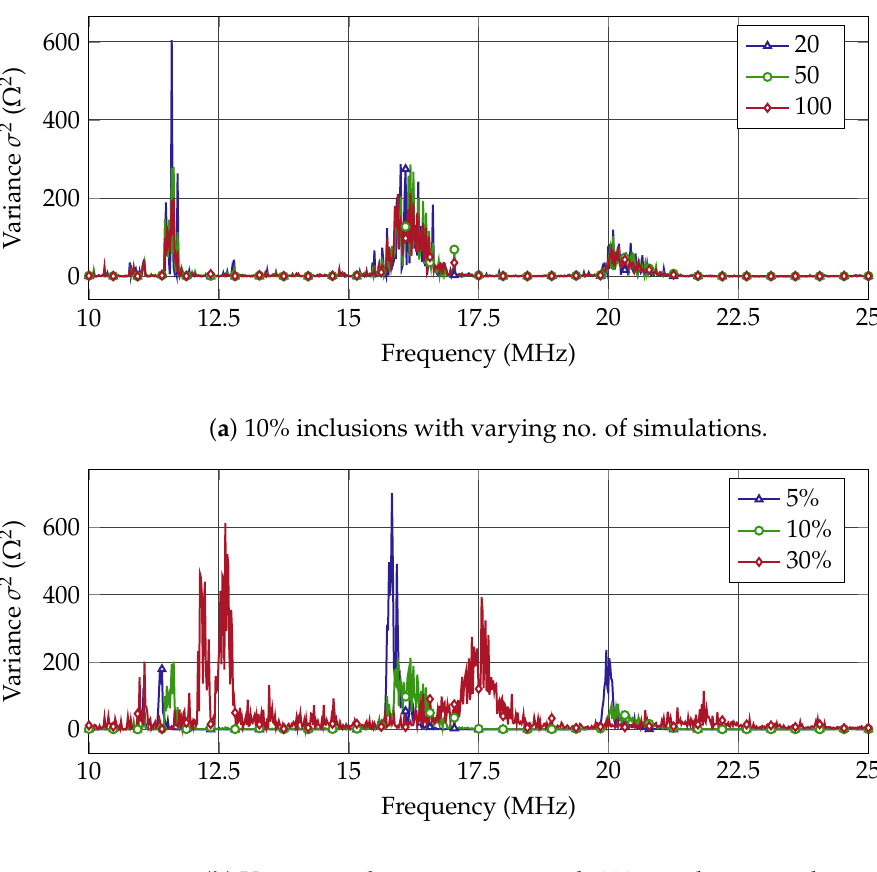
Figure 4. Comparison of extracted simulated ESR statistics from 2D simulation models of different inclusions with the first 20, 50 and 100 simulations. ( a ) shows the variance in the spread of the 10% inclusion configuration, depicting the model saturation of variation in extracted ESR with the increasing number of simulations. ( b ) compares the variance for 5, 10 and 30% LDK inclu- sions for 100 simulations in each configuration, which shows that, with increasing LDK inclusions, the acoustics suppression increases, but decreases again with a further increase in